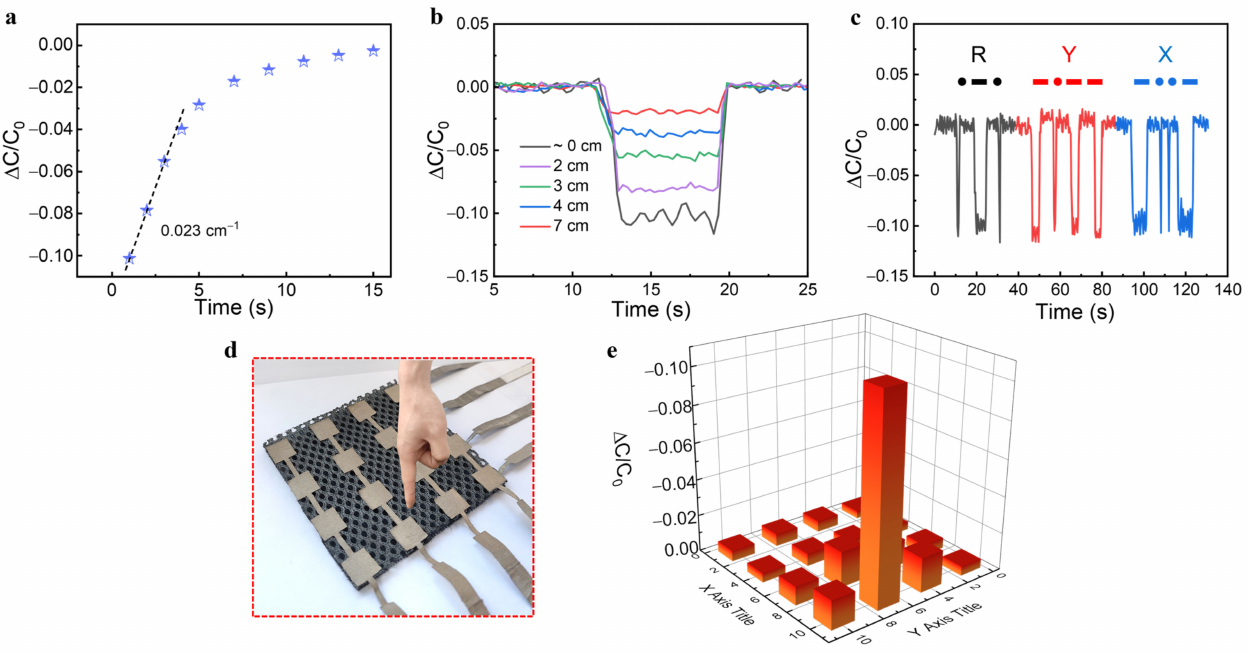
Figure 4. Non-contact sensing performance of the BAFC sensor: ( a ) relative capacitance change responding to the approaching hand; ( b ) static capacitance response at different distances between the hand and the sensor array; ( c ) international Morse password signal; ( d , e ) non-contact functionality of the BAFC sensor for the positioning finger.